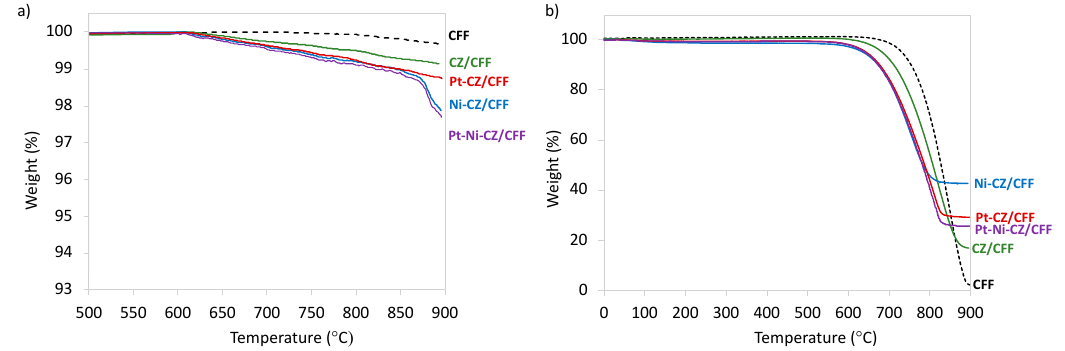
Figure 7. Thermogravimetric analysis (TGA) in N 2 ( a ) and air ( b ) for CFF (black), CZ/CFF (green), Pt-CZ/CFF (red), Ni-CZ/CFF (blue) and Pt-Ni-CZ/CFF (purple).